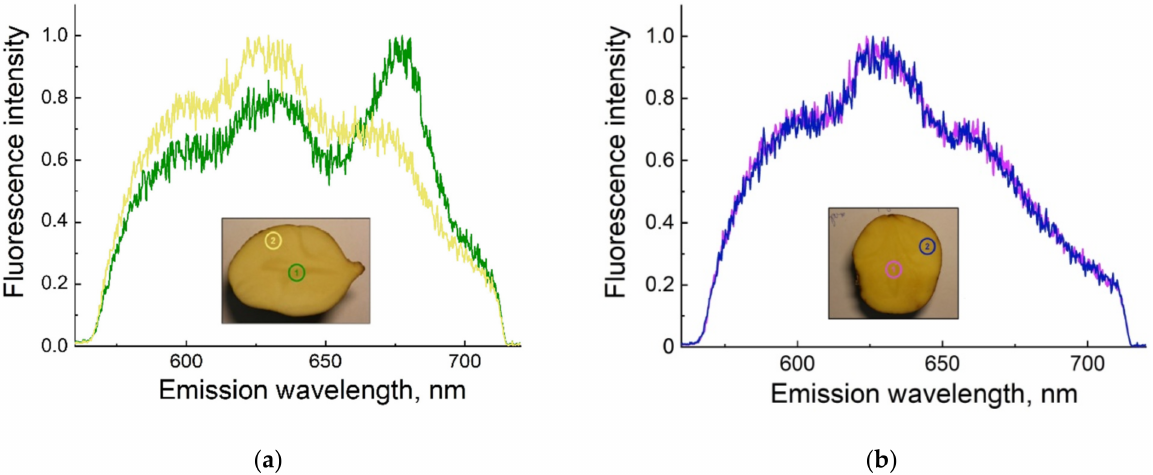
Figure 11. ( a ) Pulsed fluorescence spectra of pulp of “Udacha” (conditionally healthy) potato; ( b ) fluorescence spectra of pulp of “Zhukovsky” (conditionally rotten) potato.